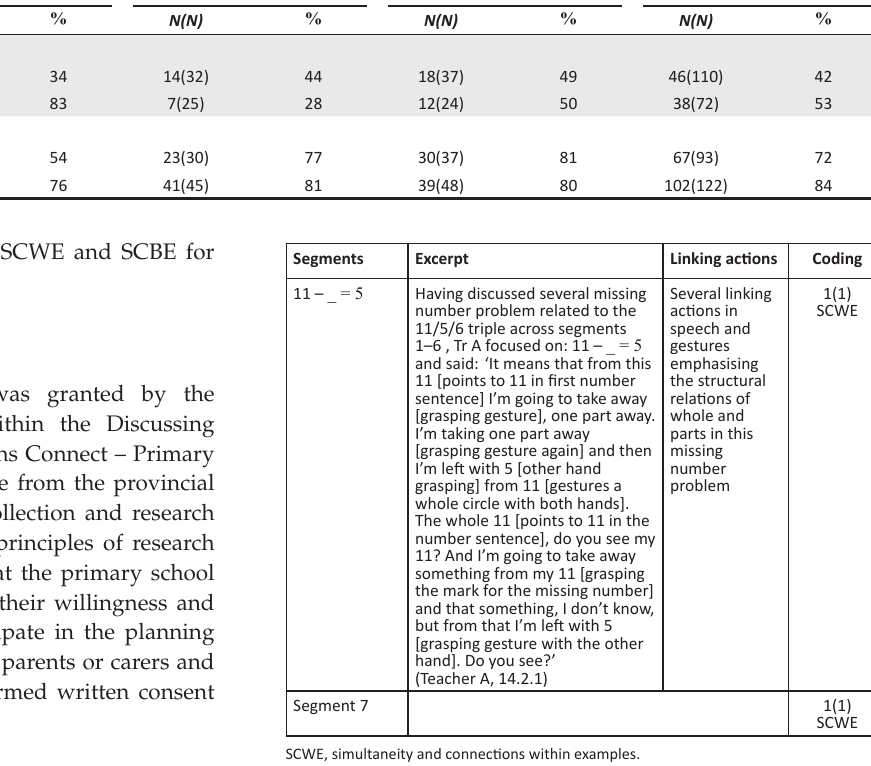
FIGURE 1: Teacher A’s instruction of missing subtrahend problem,